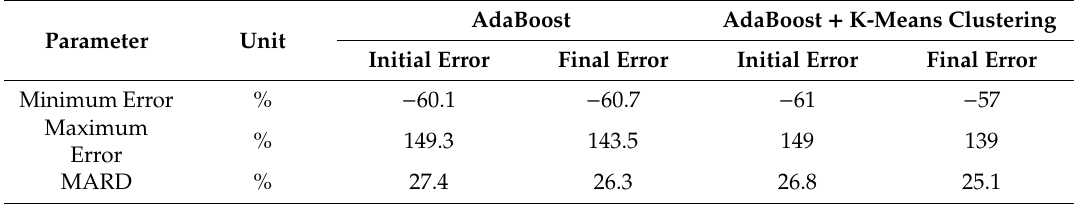
Table 7. Error and MARD reduction by di ff erent initial